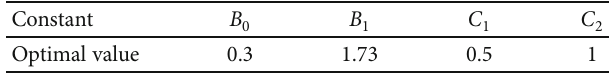
Table 2: Improved results of optimal KH-RT breakup model